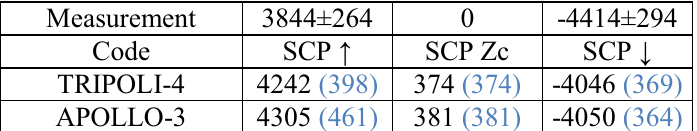
Table I. Reactivity of the core for different SCP positions and discrepancies with the measurements